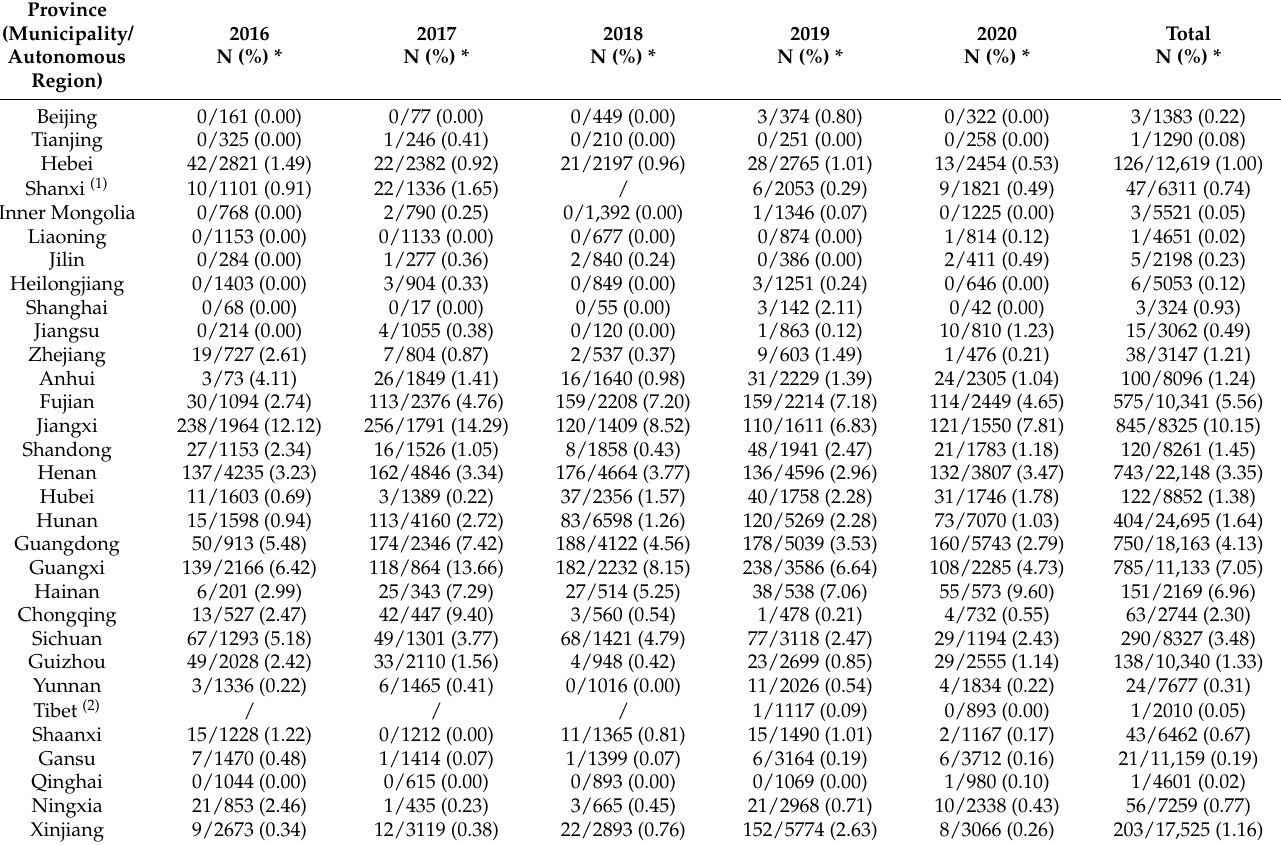
Table 1. Enterobius vermicularis infection among children aged 3 to 9 years old in China from 2016 to 2020. Province